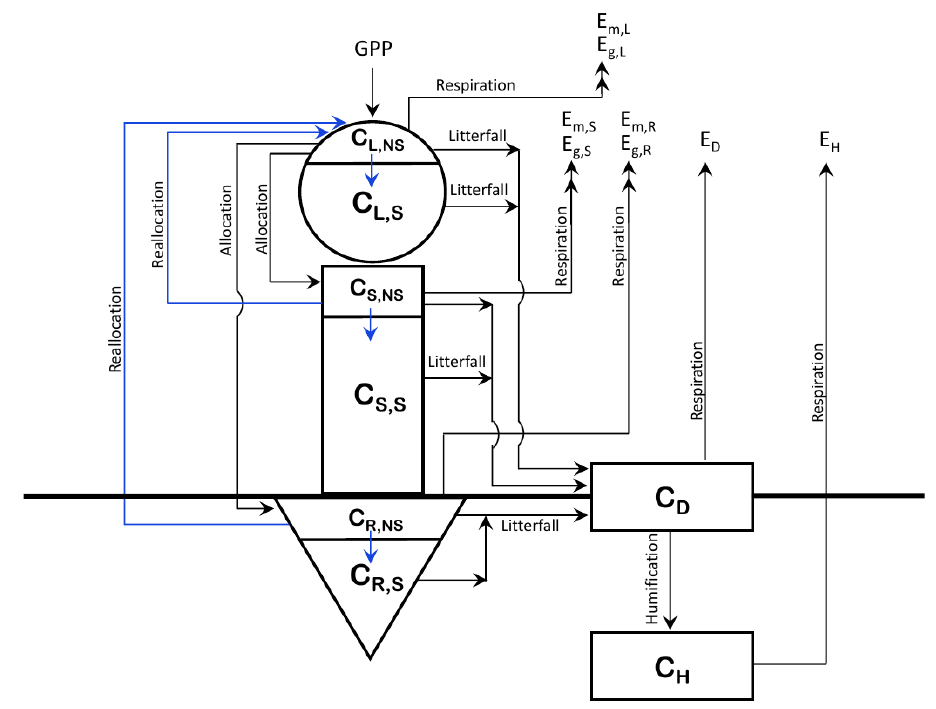
Figure 1. Schematic representation of the CTEM model after addition of non-structural carbohydrate pools. The arrows in blue show the new non-structural carbohydrate fluxes as shown in Eqs. (5) and